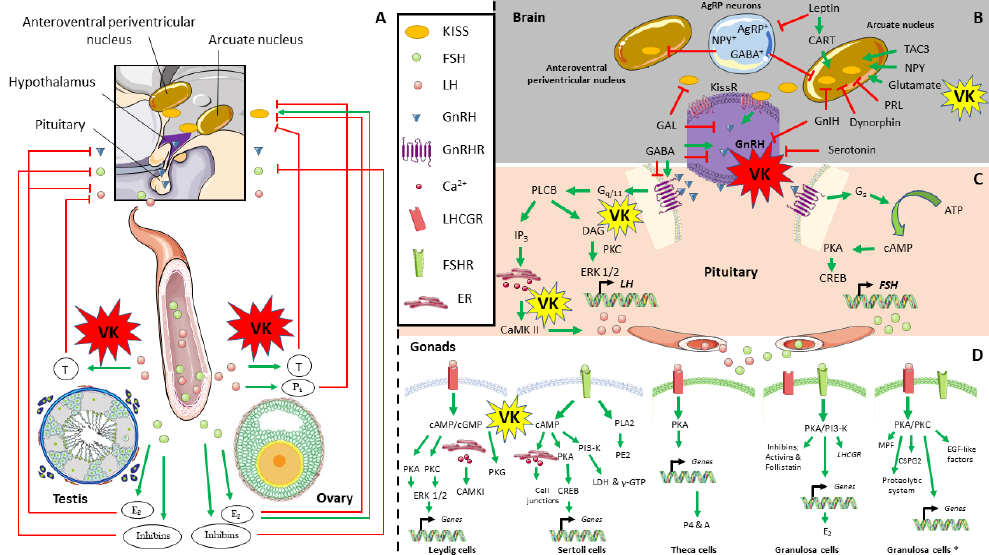
Figure 4. Hypothalamus-pituitary-gonad (HPG) axis in vertebrates and related molecular pathways. General hormonal control of the HPG axis, from neural kisspeptin stimulation to gonadal testosterone and androgens feedback regulation ( A ). Hormonal control of GnRH synthesis and release at brain ( B ). GnRH signaling pathway for FSH and LH synthesis ( C ). FHS and LH signaling pathway at specific cells from testis and ovaries: Leydig, Sertoli, Theca, Granulosa cells ( D ). The particular mechanisms by which vitamin K (VK) has a demonstrated effect on HPG axis are highlighted in red, while those showing potential evidences are highlighted in yellow. The asterisk indicates Granulosa at pre-ovulation stage, whereas green arrows and red lines indicate stimulatory and inhibitory activity, respectively. The symbol + indicates cells expressing particular genes. A , androstenedione; AgRP , agouti-related peptide; ATP , adenosine triphosphate; CAMK I , calcium / calmodulin kinase I; CAMK II , calcium / calmodulin-dependent kinase II; cAMP , cyclic adenosine monophosphate; CART , cocaine- and amphetamine-regulated transcript; cGMP , cyclic guanosine monophosphate; CREB , cAMP response element (CRE) binding protein; CSPG2 , chondroitin sulfate proteoglycan 2; DAG , diacylglycerol; E 2 , estradiol; EGF-like factors , epidermal growth factor-like factors; ERK 1 / 2 , mitogen-activated protein kinase; FSH , follicle-stimulating hormone; FSHR , follicle-stimulating hormone receptor; GABA , gamma-aminobutyric acid; GAL , galanin; Γ -GTP , γ -glutamyl transpeptidase; GnIH ,